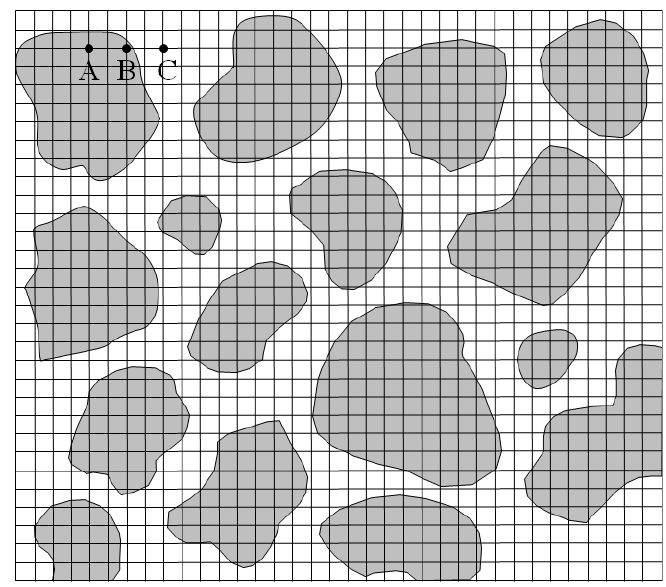
Figure 2. Mesh arrangement by the lattice Boltzmann method. Node A: lattice site in the solid domain; Node B: solid-fluid boundary lattice site; Node C: lattice site in the fluid domain. The grey areas delineate a cross-section of the solid matrix.